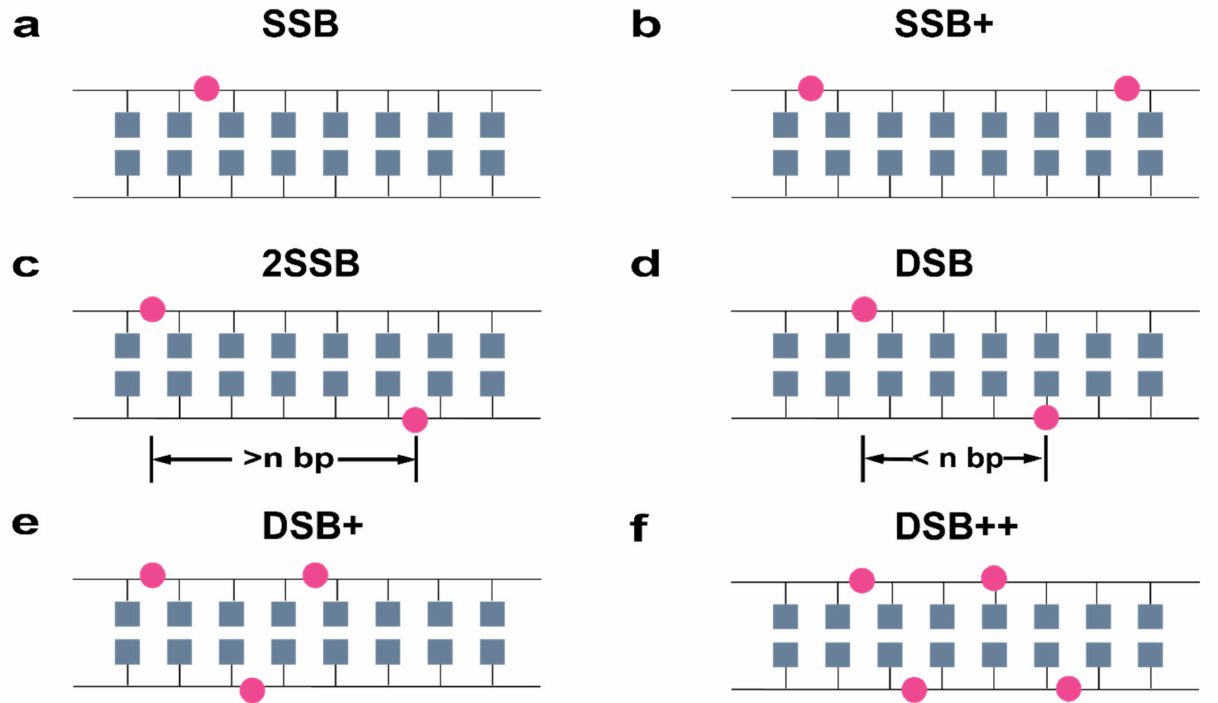
Figure 9. Schematic illustration of damage classification for the complexity of SSBs and DSBs, according to Nikjoo et al., The cube represents bases, the line represents sugar-phosphate backbones, and the circle represents damage points. ( a ) If only one SB occurs in one strand, it is classified as an SSB. ( b ) If more than one SSB occurs in the same strand, they are classified as SSB+. ( c ) If SBs are on both strands and separated by more than n base pair (bp), they are classified as 2 SSB. ( d ) If SBs are on opposite strands and separated by less than n bp, they are classified as a DSB. ( e ) If SBs have the same condition as a DSB and include an additional SSB, they are classified as DSB+. ( f ) If two or more DBSs are present in the segment, the SBs are classified as